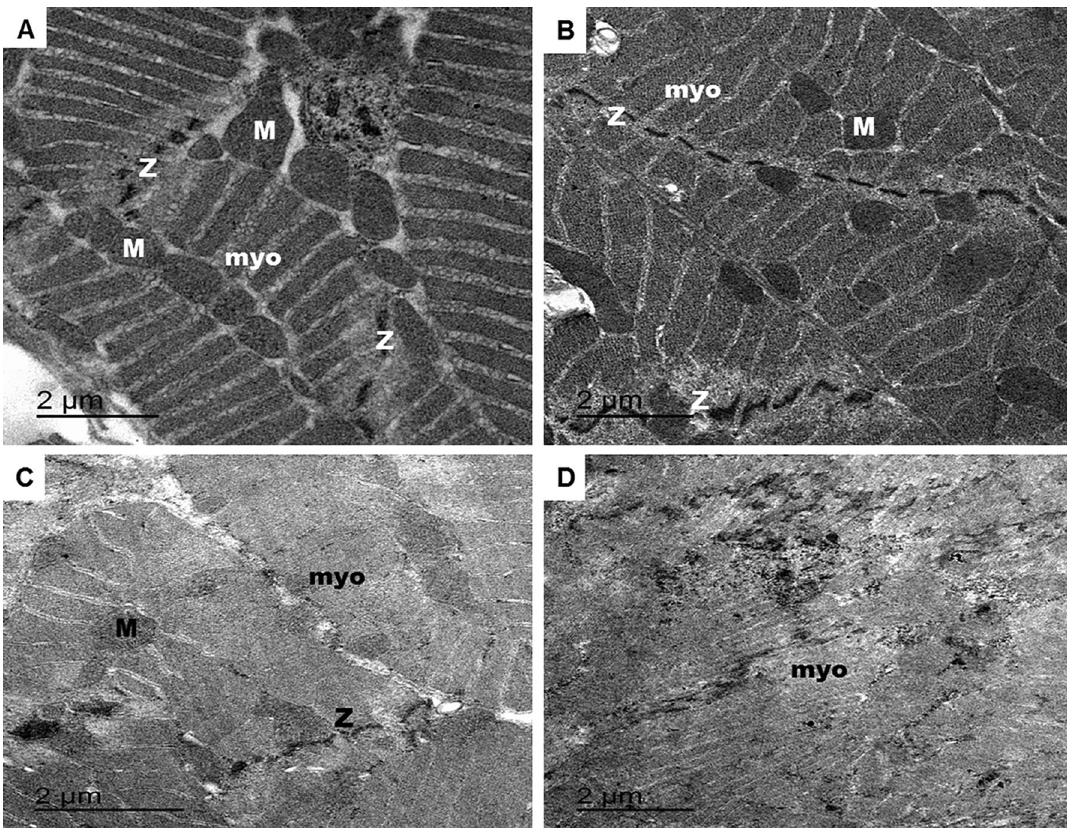
Figure 8. The effect of OctαR knocking down in the muscular system on the ultrastructure of the muscular tissue of the femur region of the hind legs as well as matching controls using mascular system driver, mhc- GAL4. ( A , B ) TEM micrograph of male flies of the controls of RNAi experiment. The muscles display features typical of insect skeletal muscle. ( C , D ) TEM micrograph of OctαR deficient flies leg muscles. M mitochondria, Myo myofibrils, Z